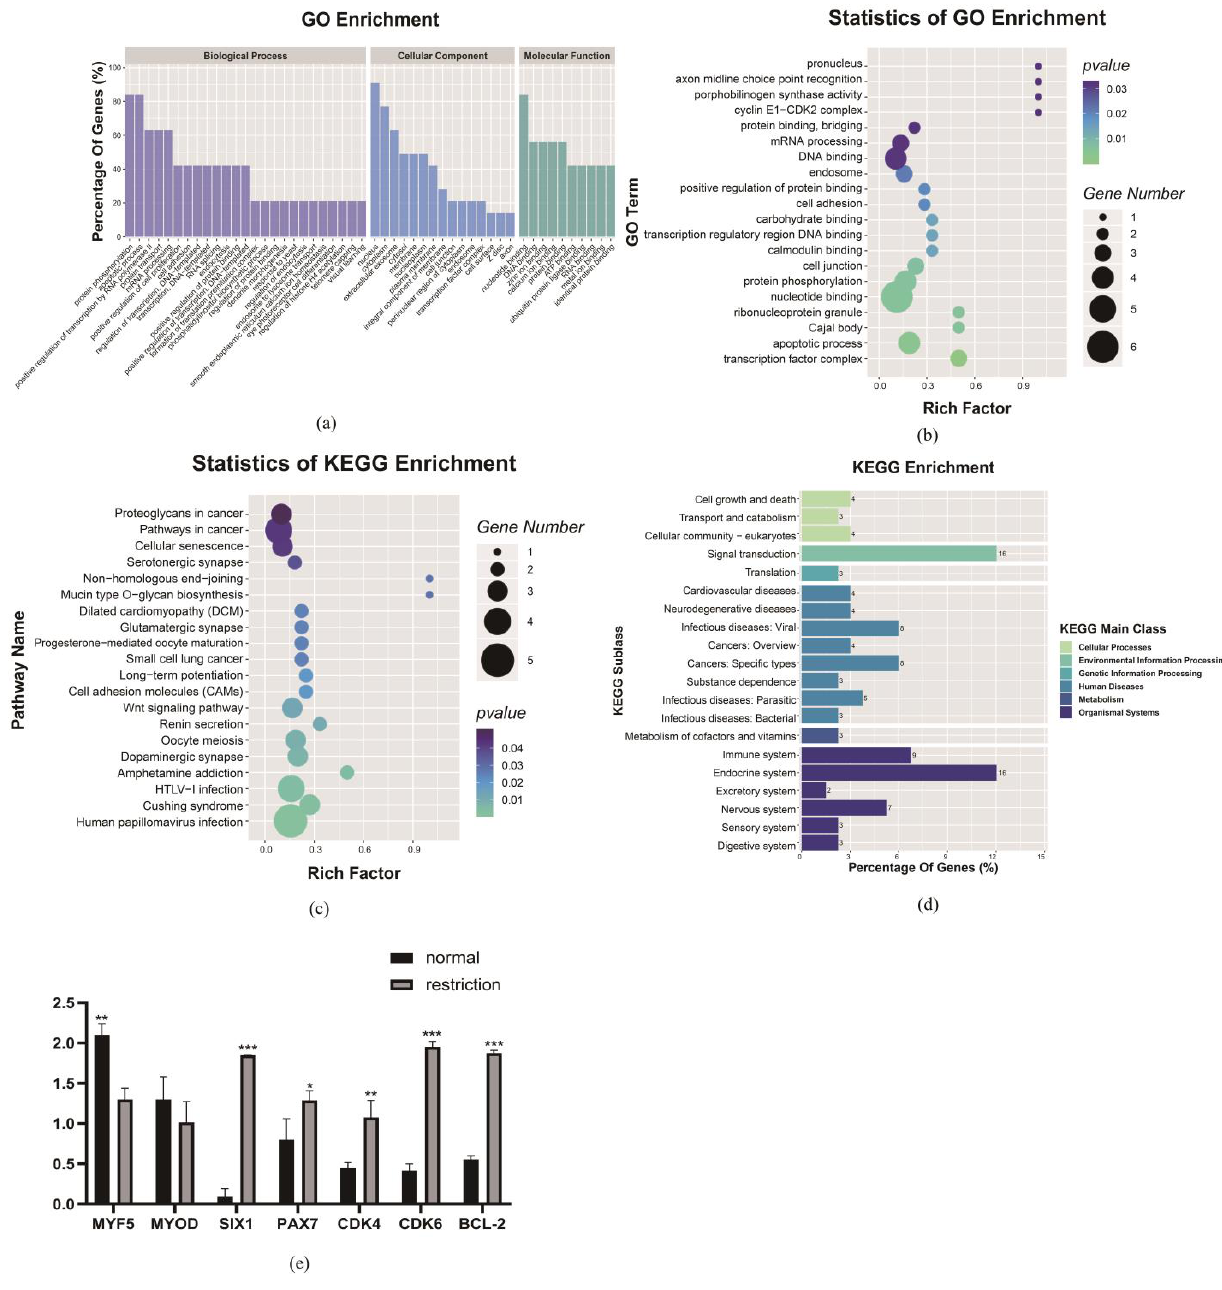
Figure 4. D85T vs. D85N differential expression mRNA-protein enrichment analysis and key candi- date gene related the gene expression analysis. ( a ) Differential expression mRNA-protein Gene On- tology (GO) term analysis; mRNA-protein, as classified into three main categories by the GO anal- ysis, purple indicates the biological process, blue indicates the cellular component and green indi- cates the molecular function. ( b ) Differential expression mRNA-protein GO enrichment analysis. ( c ) Differential expression mRNA-protein KEGG analysis, in ( b , c ), the size and color of the bubble in- dicate the number and significant characters of the differential expression mRNA-proteins. ( d ) Dif- ferential expression mRNA-protein KEGG enrichment analysis and the orthologous signaling path- ways are classified into different functions. ( e ) CDK2 -related gene expression analysis, p < 0.05 (*), p < 0.01 (**) or p < 0.001 (***).